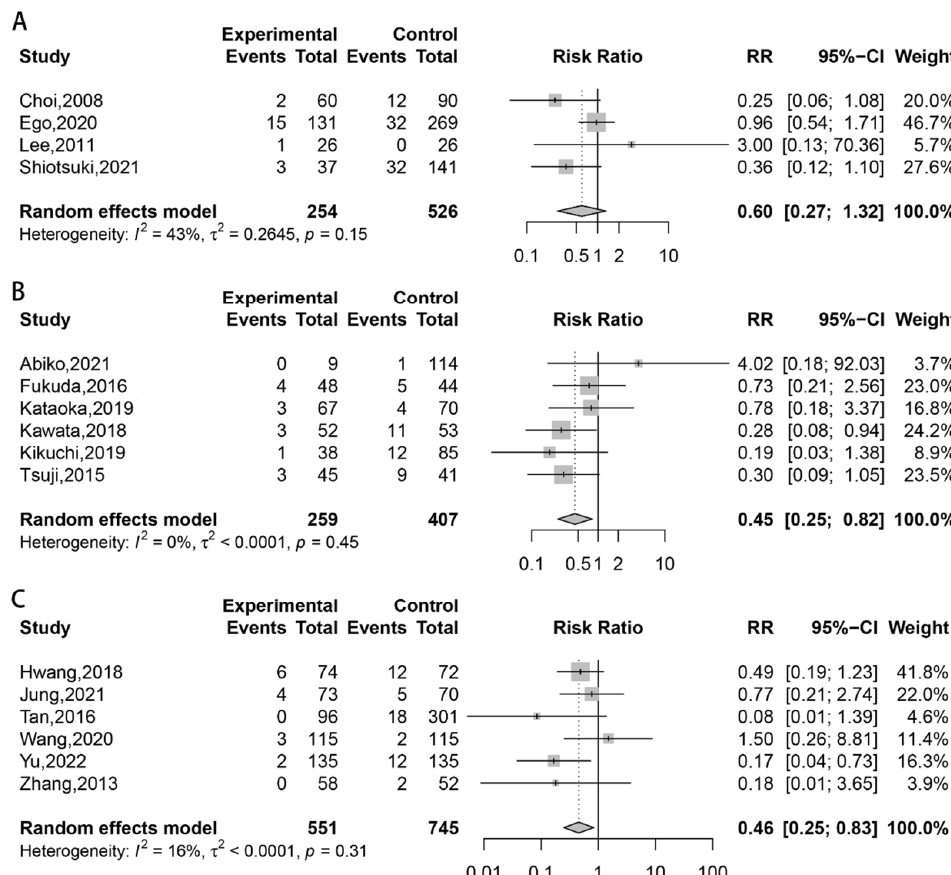
Figure 2. The efficacy of different endoscopic approaches for the prevention of delayed bleeding after gastric ESD, according to pair-wise meta-analysis: ( A ) Endoscopic closure group vs. control group [32,33,38,41]; ( B ) Tissue shielding group vs. control group [10,43–46]; ( C ) Hemostatic spray group vs. control group. Block and whisker: point estimate and 95% confidence interval (CI) of the primary study. Its relative size and proximity to the meta-analysis pooled estimate are proportional to primary study relative weight. Grey diamond: Pooled estimate of effect size. Its width corresponds to its 95% CI [19,52,53,55–57].